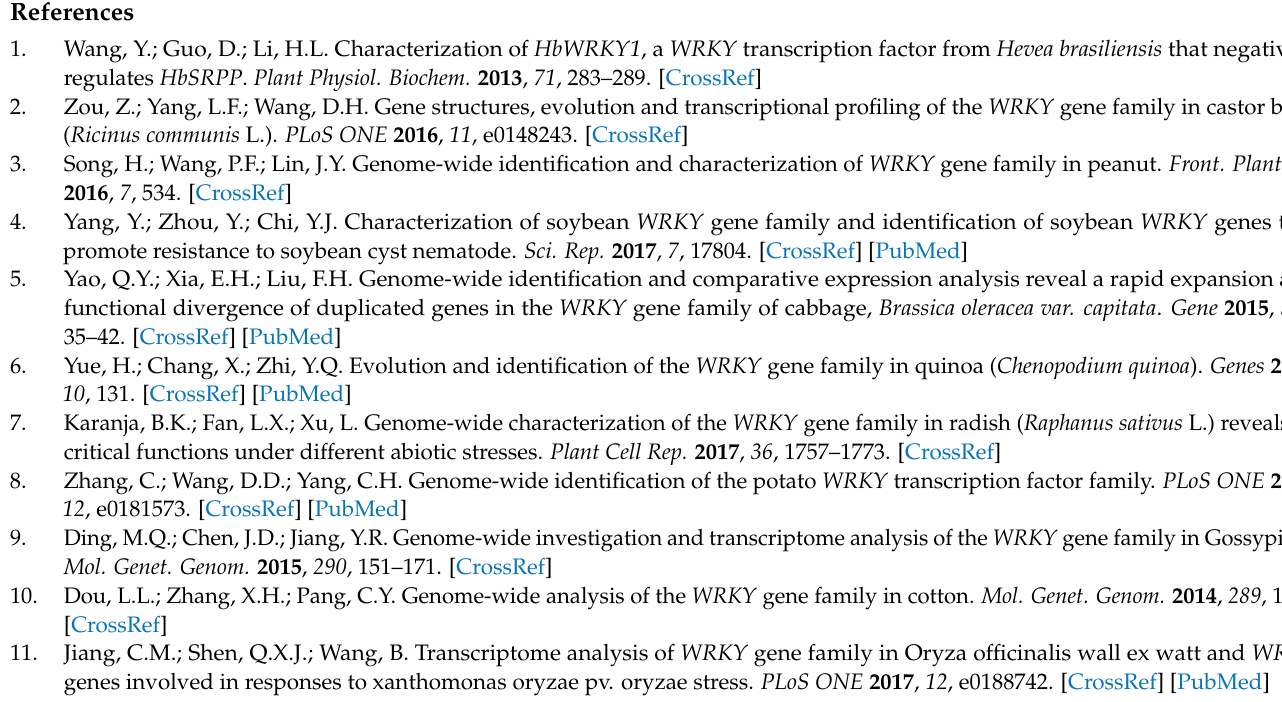
Supplementary Materials: The following are available online at https://www.mdpi.com/article/10 .3390/genes12091444/s1, Figure S1. Expression profiles of the walnut WRKY genes among 17 tissues; Figure S2. Expression profiles of the walnut WRKY genes between anthracnose-resistant F26 and anthracnose-susceptible F423 were used in this study; Table S1. The transcriptome data were used in this study; Table S2. Primers used for quantitative real-time PCR; Table S3. The sequence of WRKY gene family. Table S4. The gene structure information of WRKY genes; Table S5. The collinearity in J.regia and their related information; Table S6. The ka/ks value of WRKY genes in walnut; Table S7. The collinearity in J. regia , A. thaliana , J. mandshurica , J. microcarpa , P. trichocarpa and Q. robur and their related information; TableS8. The KEGG enrichment analysis of WRKY genes in J. regia ; Table S9. The WRKY genes expression level in different tissues of J. regia ; Table S10. The WRKY genes expression level in AR and AS fruits; Table S11. The qPCR data of three genes; Table S12. The predicted miRNA sequence target WRKY genes; Table S13. The target WRKY genes sequence was targeted by miRNAs; Table S14. The predicted miRNA and target genes interaction network; Table S15. The regulatory network relationships between putative miRNAs and JrWRKY73 ; Table S16. One-to-one orthologous relationships between Juglans regia and Arabidopsis thaliana